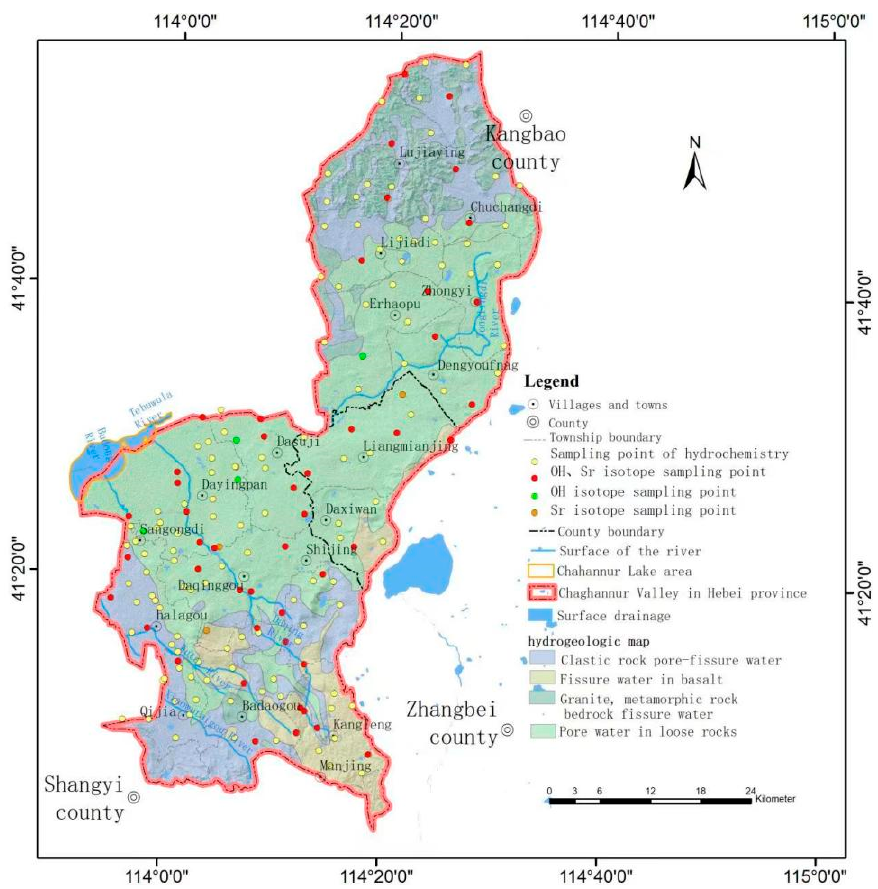
Figure 2. Plume distribution of the groundwater pollution in the study area.